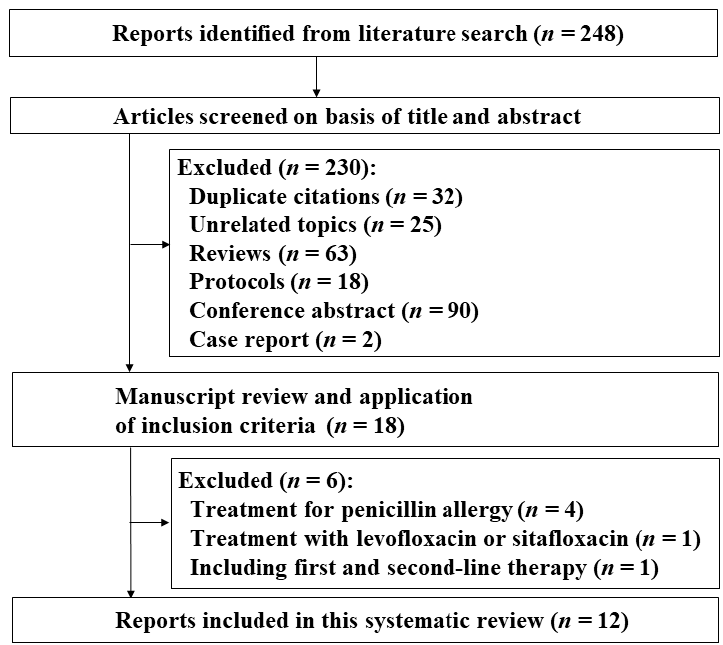
Figure 1. Flow diagram of the systematic literature search.